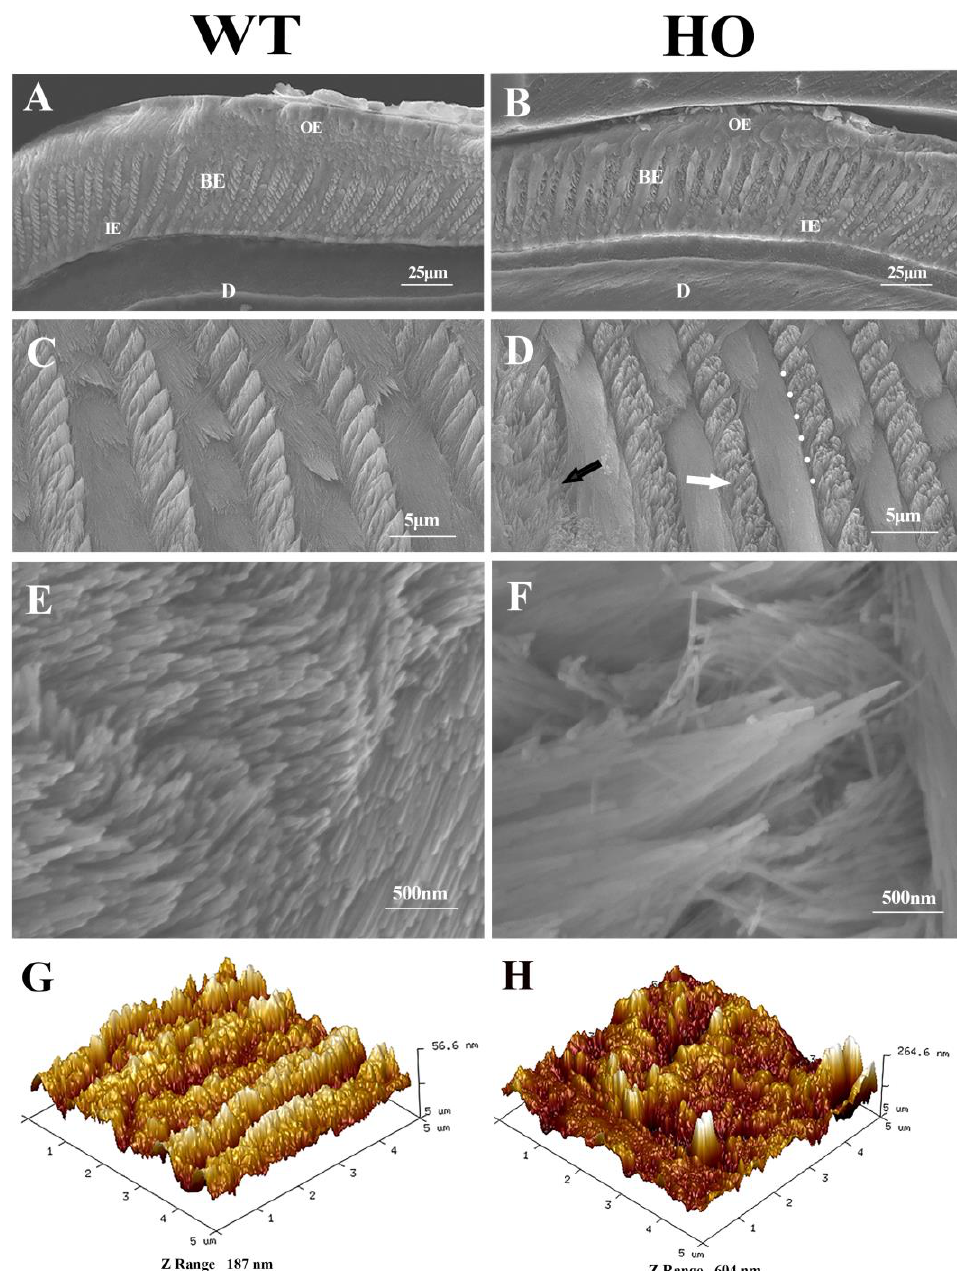
Figure 4. SEM image and topography of the enamel prismatic structure: ( A , B ) Cross-section of axial enamel layer in the first molars. OE: Outer enamel; BE: Body enamel; IE: Inner enamel; D: Dentin. ( C ) Typical columnar structure of enamel prisms in WT mice enamel. ( D ) HO mice enamel showed distorted and sparse areas (white arrow) composed of cluttered nanofibrous apatites (black arrow), with wider interprismatic gaps (dots marked). ( E ) Regular packing crystals in WT mice enamel. ( F ) Crystallites lined up in disorder with large spaces between prisms in HO mice enamel. ( G , H ) AFM showed regular decussation in WT mice. HO mice enamel appeared with collapsed and fused prisms and large cracks through interprisms.